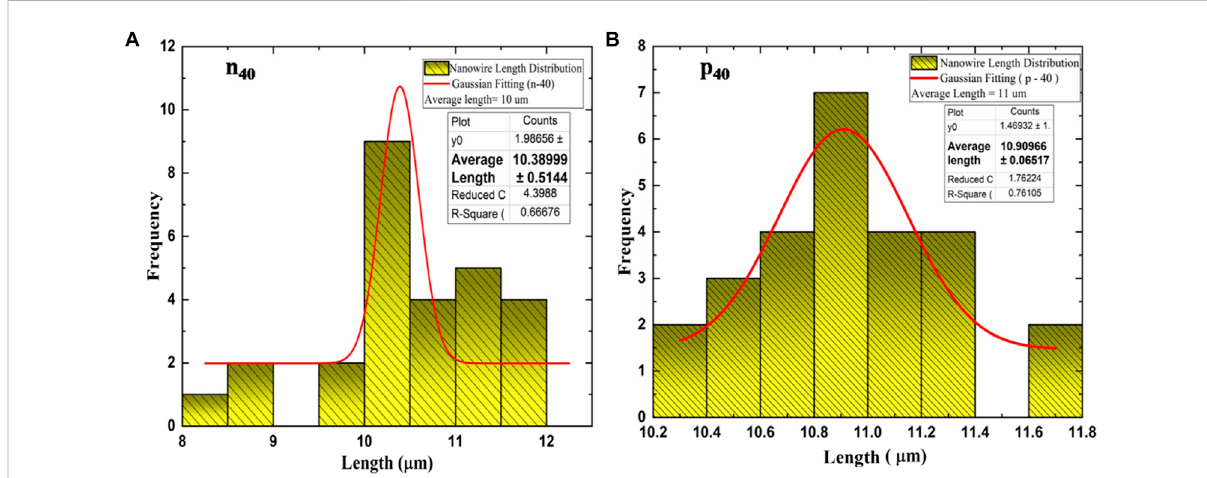
FIGURE 3 Average length of the Si NWs (A) n 40 and (B) p 40 using ImageJ software.